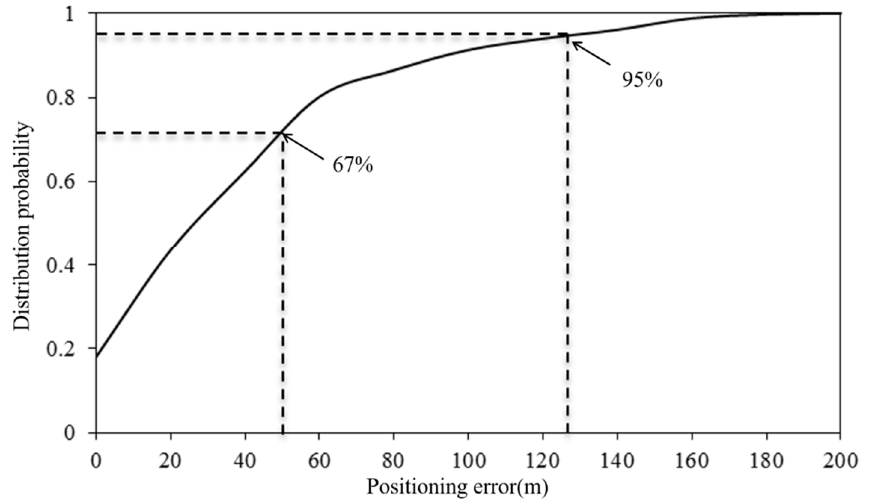
Figure 6. WFA cumulative distribution probability.